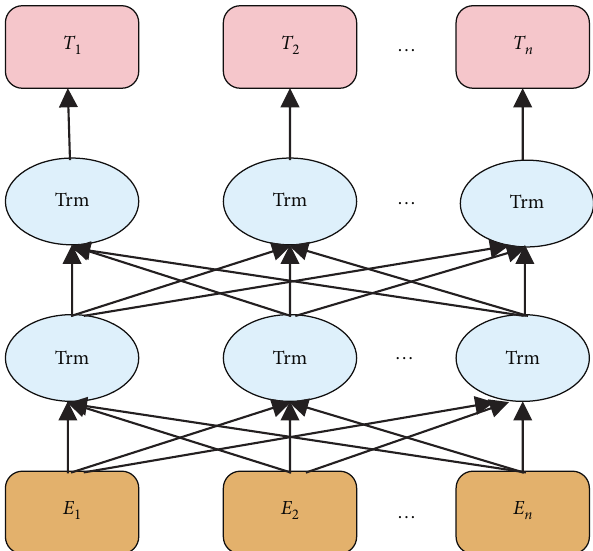
Figure 2: BERT network model.